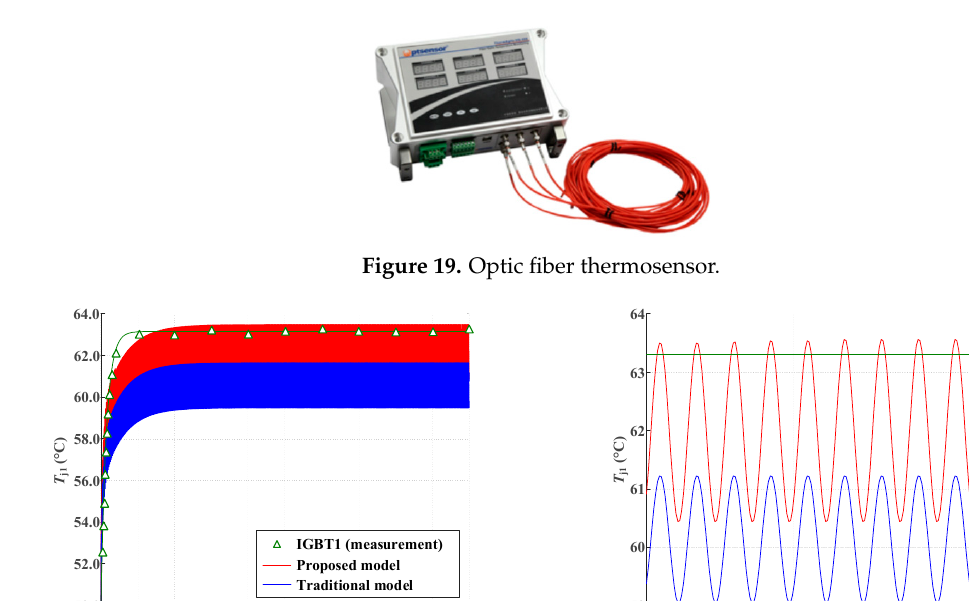
Figure 18. Front view of type test setup with thermos-sensors.